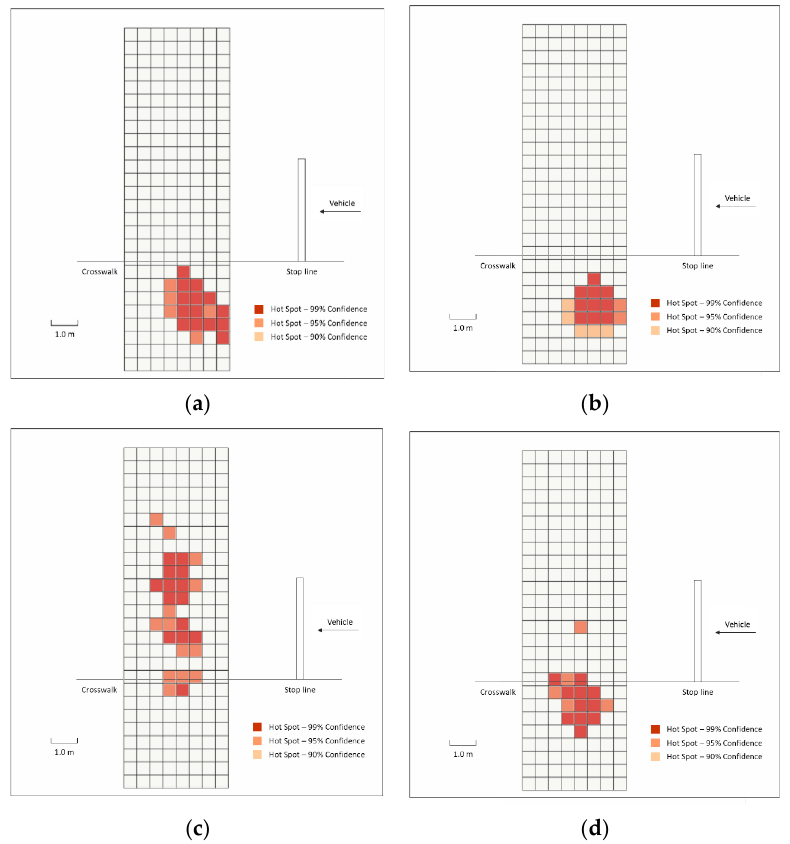
Figure 5. Hot spot analysis of pedestrian’s position in Group 1 (CV) and Group 2 (AV). ( a ) Group 1 at −7.0 s . ( b ) Group 2 at −7.0 s . ( c ) Group 1 at 0 s. ( d ) Group 2 at 0 s.